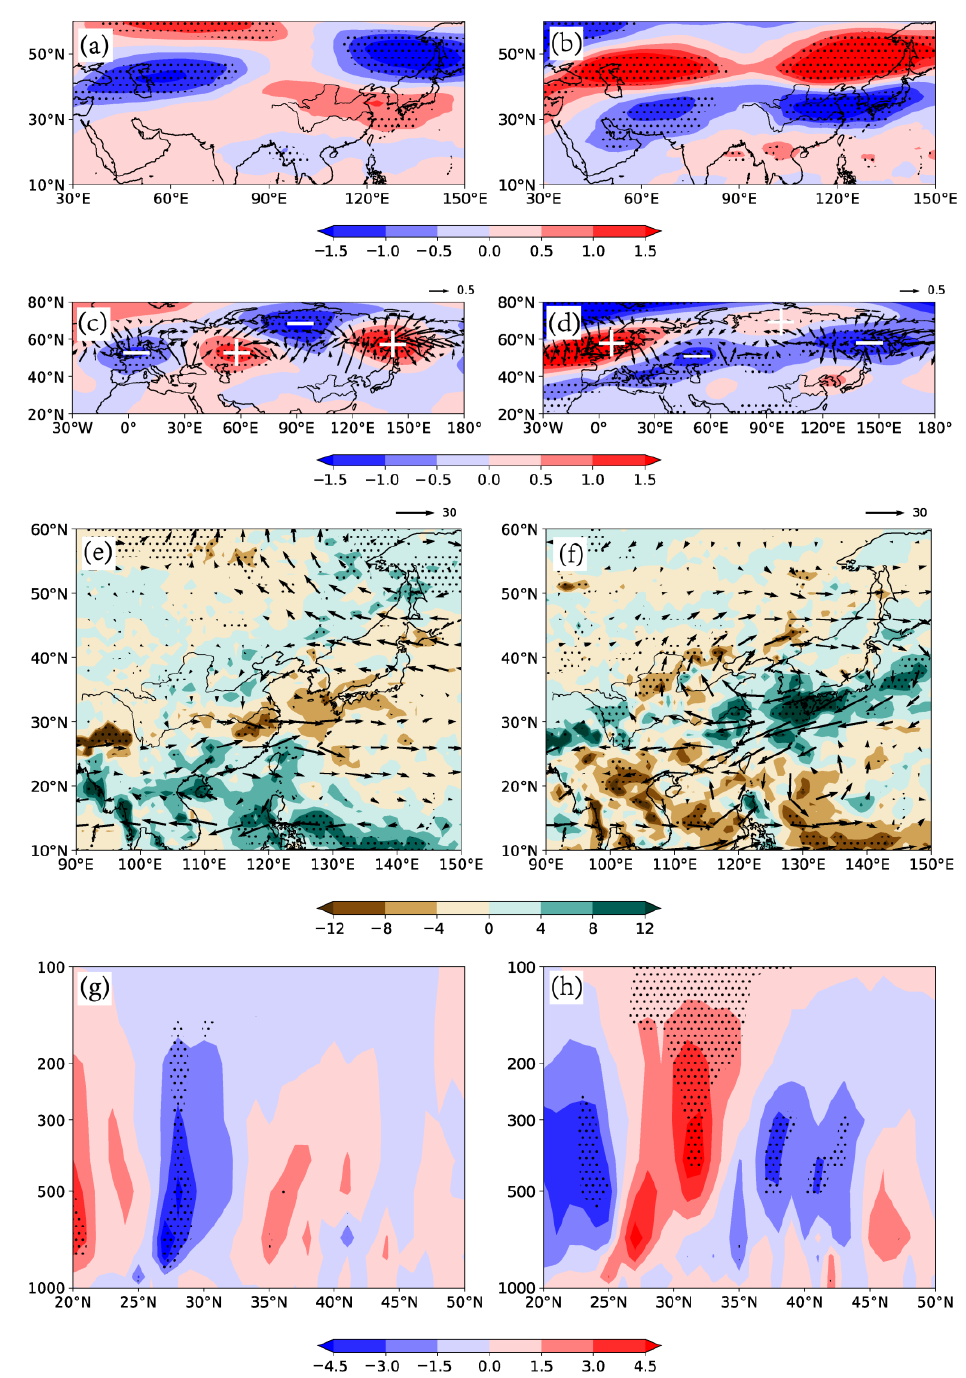
Figure 7. Regression of summer ( a , b ) zonal wind at 200 hPa (units: m·s −1 ), ( c , d ) geopotential height at 500 hPa (units: dagpm) and wave activity fluxes (vector, units: m 2 ·s −2 ), ( e , f ) vertical integral of moisture flux (vector, units: kg·m −1 ·s −1 ) and its divergence (shading, units: 10 −6 kg·m −2 ·s −1 ), ( g , h ) ver- tical velocity averaged along 90° E to 120° E (units: 10 − 3 Pa·s −1 ) onto ( a , c , e , g ) the CI and ( b , d , f , h ) the NAO index. The areas significant at the 95% confidence level are dotted.